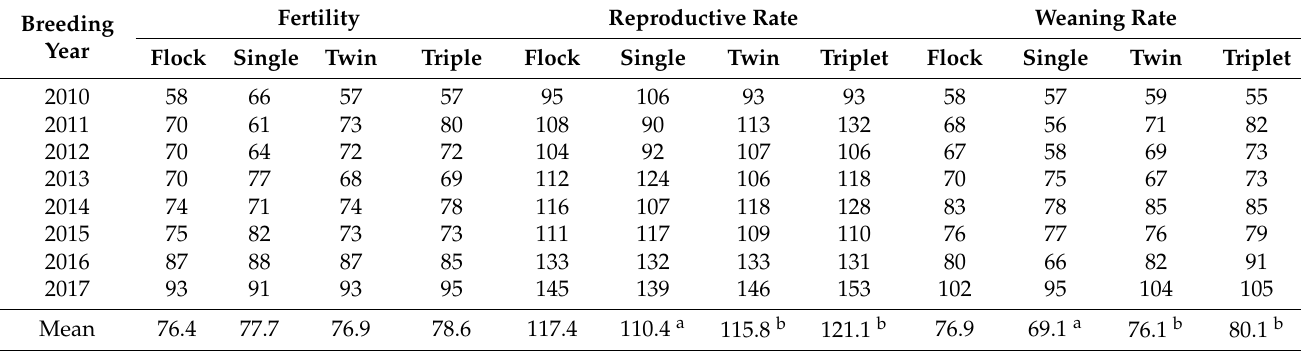
Table 3. Average fertility rate (% ewe lambs pregnant), reproductive rate (fetuses scanned per 100 ewes bred) and weaning rate (offspring weaned per 100 ewes bred) for the whole flock and single-, twin- and triplet-born maternal composite ewe lambs from 2010 to